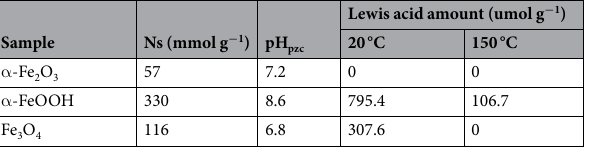
Table 1. Surface area, surface hydroxyl site density (Ns), pH pzc and Lewis acid amount degassing at 20 and 150 °C of α -Fe